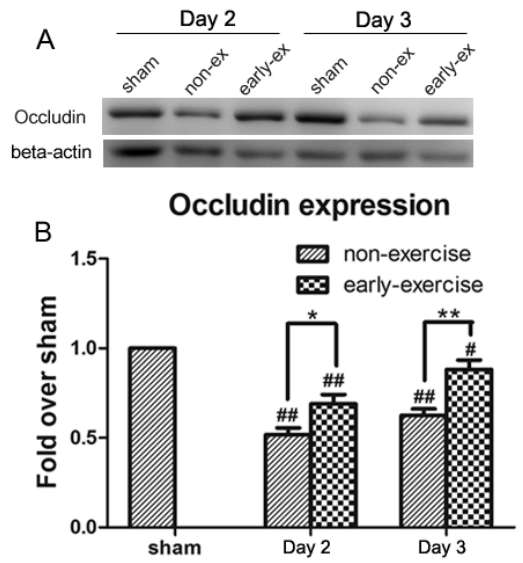
Figure 8. Effect of early exercise on the expression of occludin protein following focal cerebral ischemia. ( A ) Representative bands of occludin expression in ischemic brains following MCAO detected by Western blotting; ( B ) Quantification of the optical density of the occludin bands, normalized to beta-actin. There was a significant upregulation of occludin expression in the EE group. * p < 0.05 and ** p < 0.01, compared with the NE group; # p < 0.05 and ## p < 0.01, compared with the sham group. n =